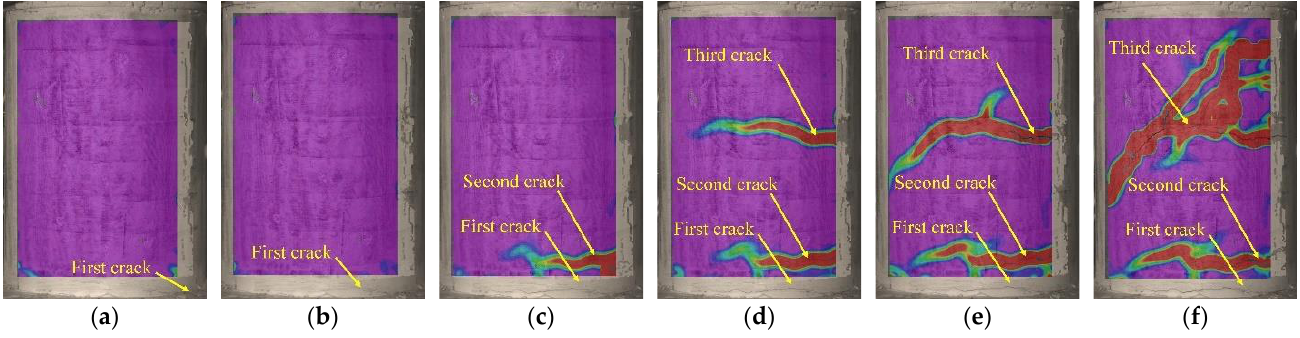
Figure 20. Principal strain nephograms of test specimen G3. ( a ) 33 kN; ( b ) 44 kN; ( c ) 64 kN; ( d ) 69 kN; ( e ) 80 kN; ( f ) 90 kN.